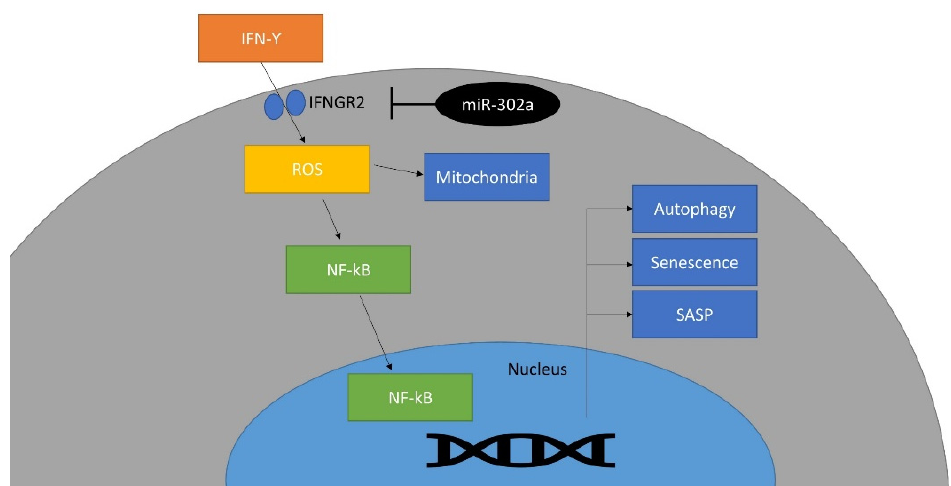
Figure 7. Schematic diagram of the effect of miR-302a on IFN- γ signaling pathway. This miRNA targets IFNGR2 and inhibits IFN- γ signaling pathway.